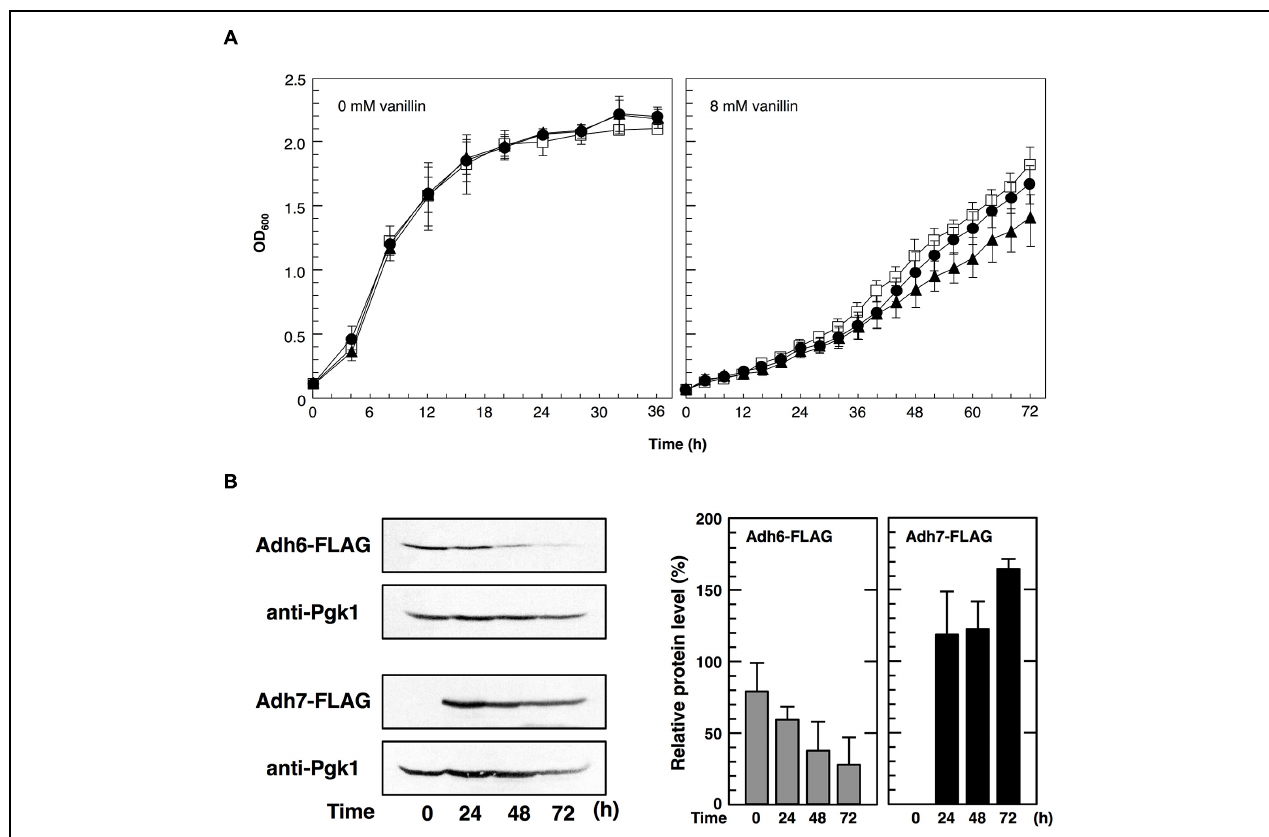
FIGURE 4 | Cells were cultured at 28 ◦ C in SD medium containing 8 mM vanillin. (A) Growth of adh6 (cid:2) and adh7 (cid:2) cells was monitored by measuring the optical density at 600 nm (OD 600 ). Data are shown as the mean ± SD of three independent experiments. The strains examined were as follows: open squares, wild type; closed circles, adh6 (cid:2) ; closed triangles, adh7 (cid:2) . (B) Changes in Adh6 and Adh7 levels during cultivation were monitored by western blot analysis using an anti-FLAG antibody. Pgk1 was used as a loading control. Protein levels of Adh6 and Adh7 were normalized to that of Pgk1 using ImageJ, and the intensity of Pgk1 band of each lane was considered 100%. Data are shown as the mean ± SD of three independent